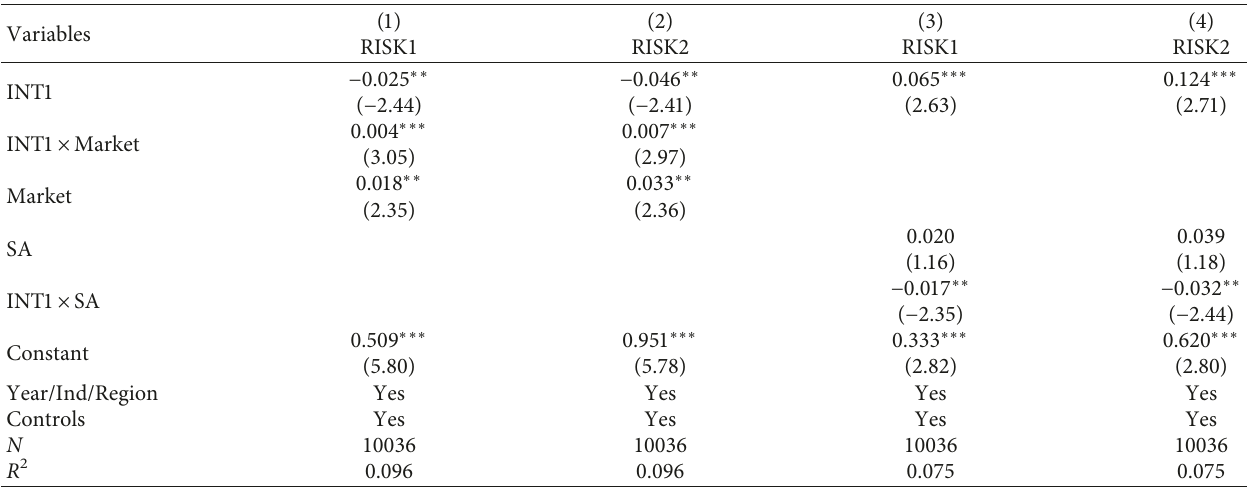
Table 7: Moderation effect testing.